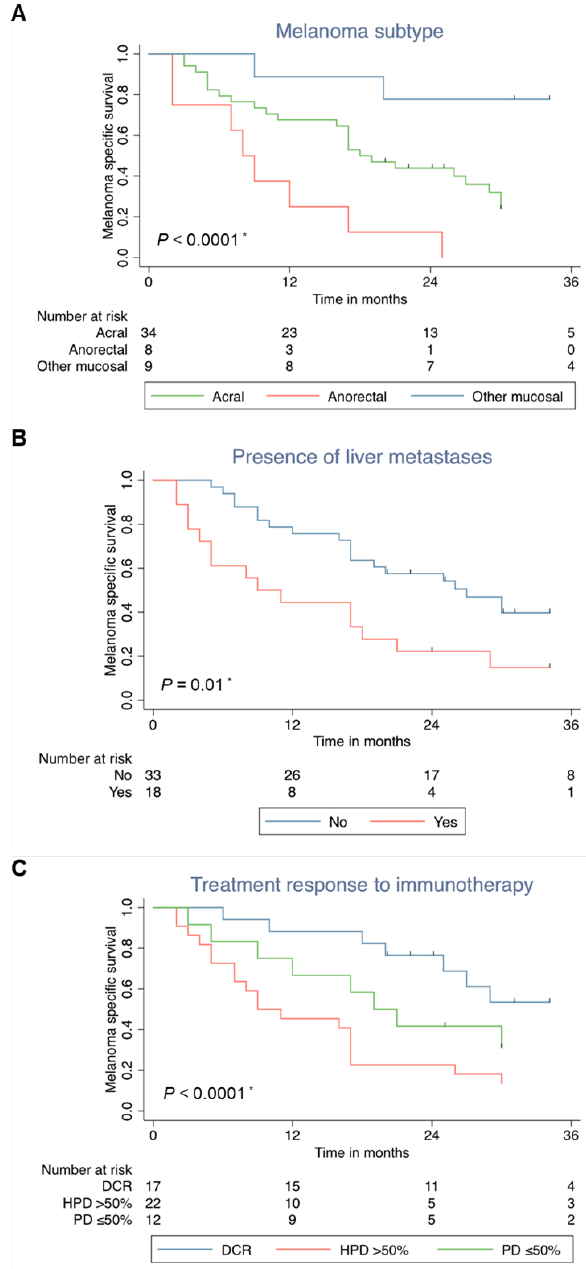
Figure 4. Melanoma specific survival according to ( A ) melanoma subtype (acral, anorectal, other mucosal melanoma), ( B ) liver metastases (present, absent) ( C ) response to checkpoint inhibitor (disease control, progressive disease, hyper-progressive disease). * significant difference in the Log rank test.